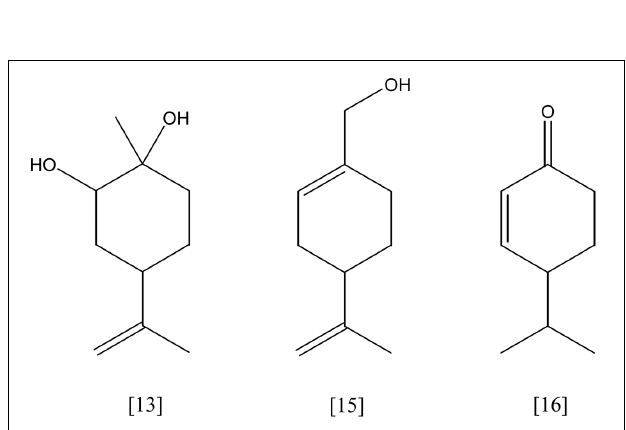
FIGURE 5 | limonene-1,2-diol [13]; perillyl alcohol [15]; cryptone [16].